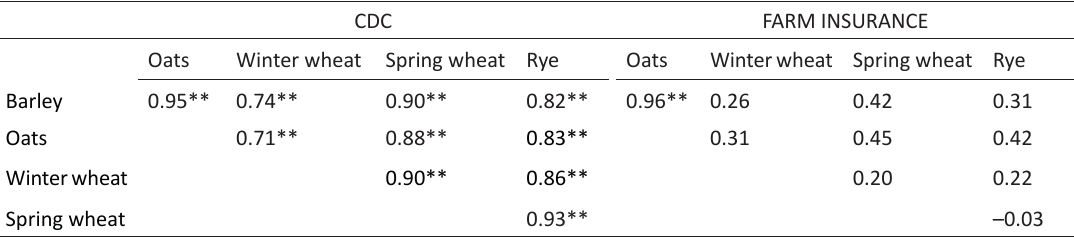
Table 2. Bivariate rank correlations for barley, oats, winter wheat, spring wheat and rye based on CDC and FADN data